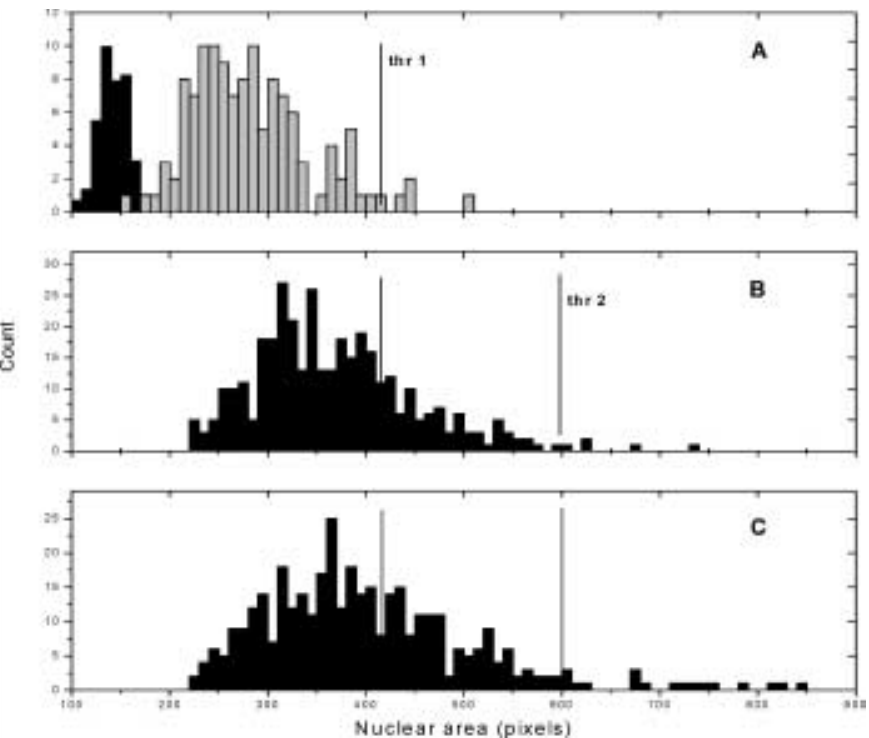
Fig. 3. Histogram of nuclear area for individual cell nuclei within a single case. A: lymphocyte (solid) and normal (uninvolved) cells (grey). B: DCIS component of the lesion. C: Invasive component. The vertical line at thr1 represents the cutoff value for grade 1 nuclei (mean + std. error), and at thr2 the cutoff value for grade 2